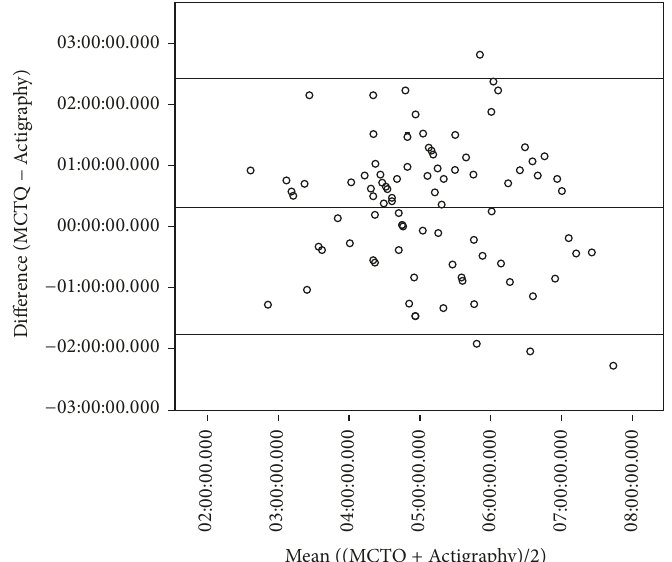
Figure 3: Bland-Altman plot comparing the MCTQ and actigraphy-derived corrected midpoints of sleep. Upper and lower lines present the 95% limits of agreement. Middle line represents the mean difference between the measures.